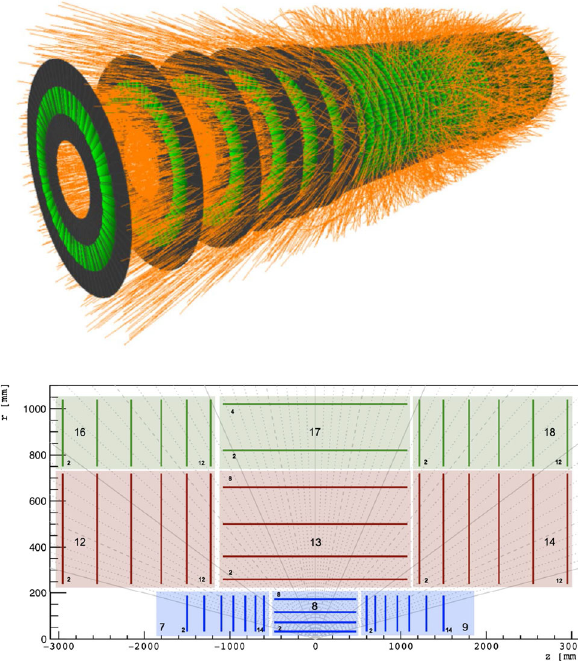
Fig. 1 A simulated HL-LHC collision event (top) as seen by the TrackML tracking detector [2]. The detector schematic (bottom) shows the top half of the detector projected on the r-z plane. The z-axis is along the beam direction